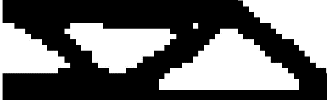
Figure 5. Final results from 10 runs of the MBB beam.